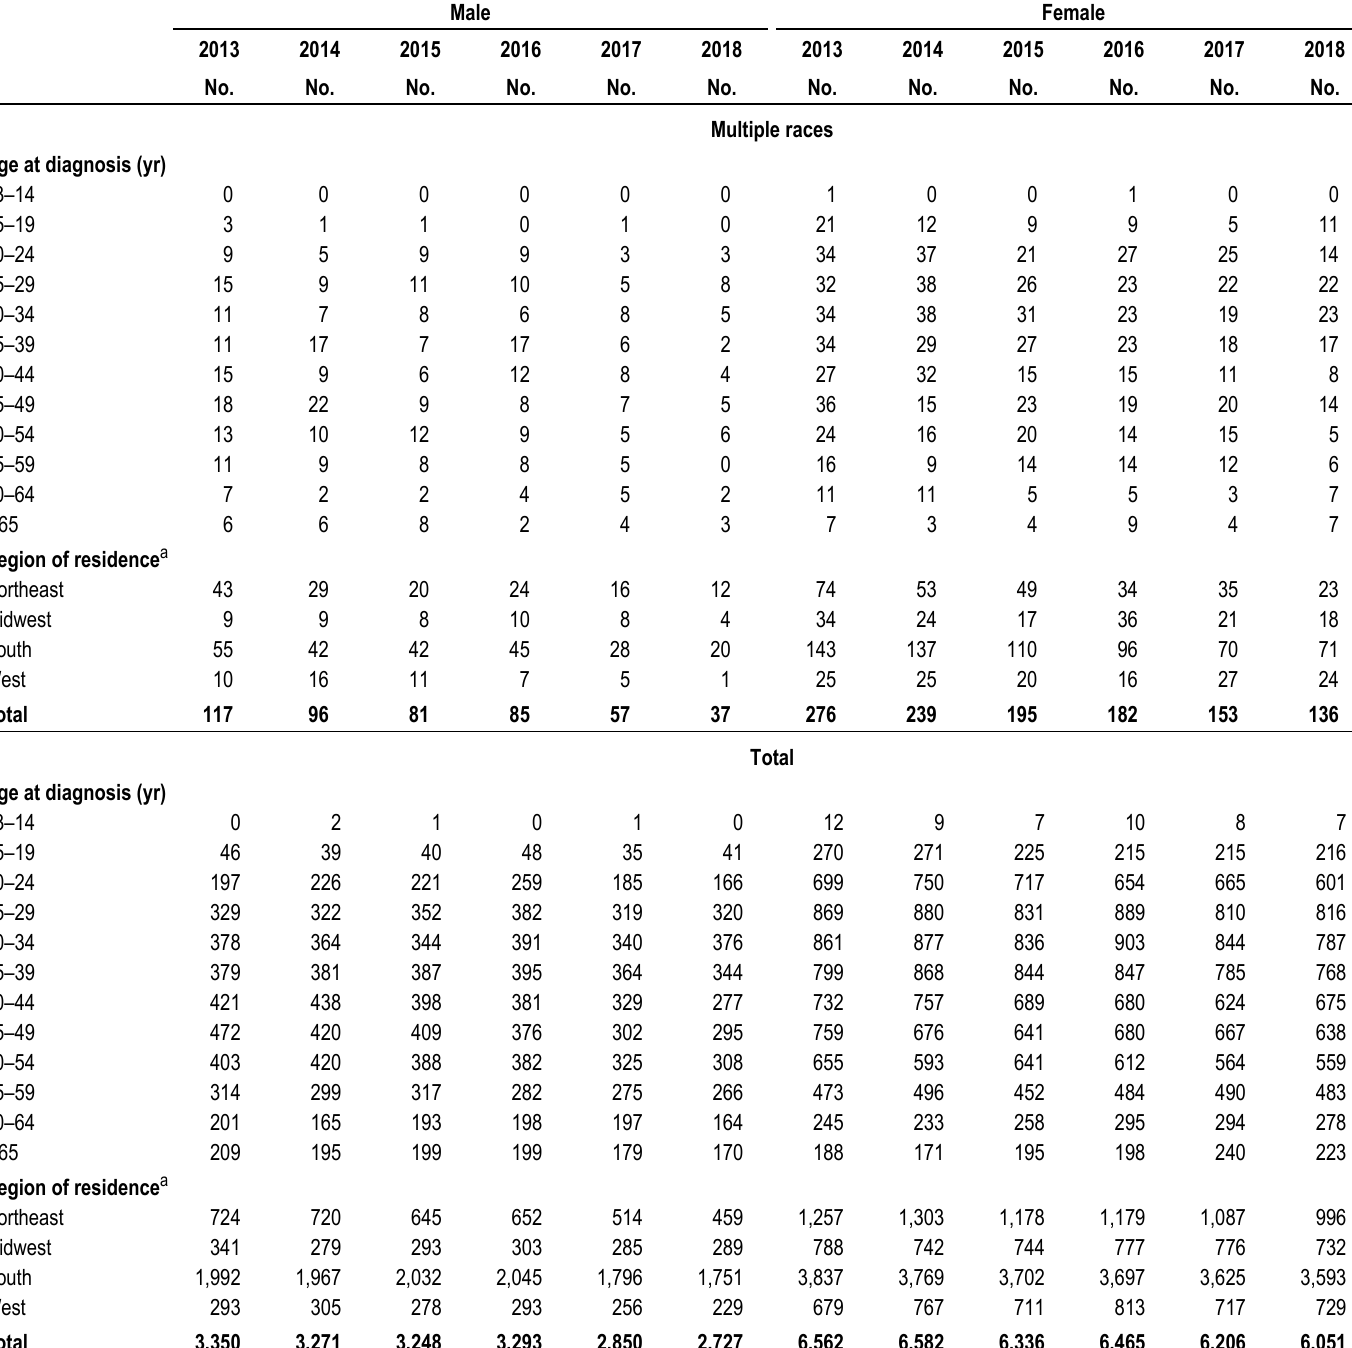
Table 9a. Diagnoses of HIV infection attributed to heterosexual contact, by selected characteristics, 2013–2018—United States (cont) Male